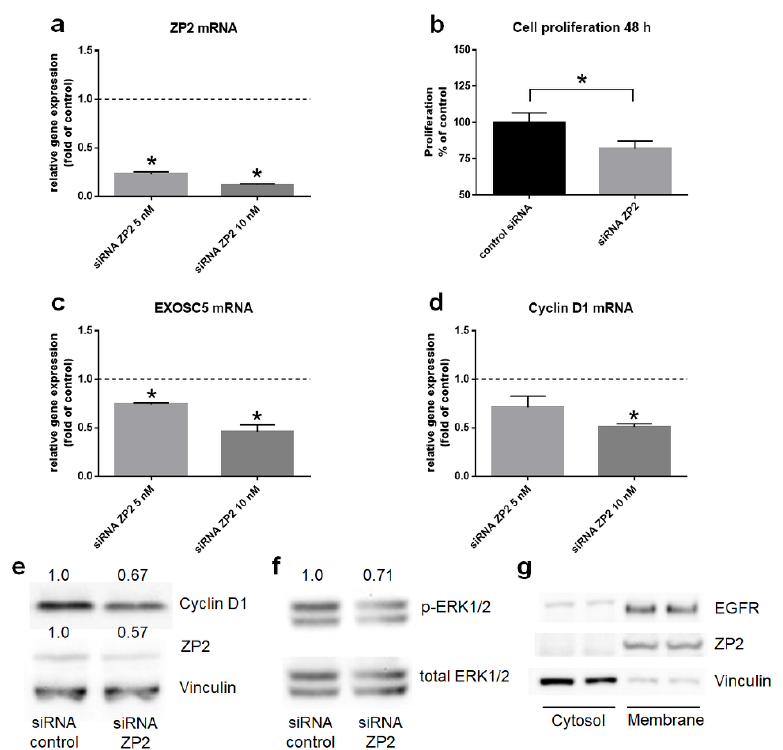
Figure 6. ZP2 silencing effects on colon tumor HT29 cells. ( a ) Decreased expression level of ZP2 after 48 h treatment with its siRNA compared to control siRNA. Untreated control showed no difference compared to control siRNA. Statistically significant differences to control with p < 0.05 are shown with asterisks (*). ( b ) Reduction of cell proliferation rate after treatment with 10 nM siRNA for ZP2 compared to non-stimulated cells as control (= 100% at y-axis). Statistically significant difference with p < 0.05 is shown with an asterisk (*). ( c ) Decreased EXOSC5 mRNA level after incubation with siRNA for ZP2 compared to control siRNA. Statistical significant differences ( p < 0.05) compared to control are designated with asterisks (*). ( d ) Reduced cyclin D1 transcript level after incubation with siRNA for ZP2 compared to control siRNA. Asterisk (*) shows statistically significant difference ( p < 0.05) to control. ( e ) Western blot analysis for cyclin D1 and ZP2 after treatment of HT29 cells with siRNA for ZP2. Vinculin served as internal standard. Numbers show fold change of signal compared to control siRNA (set as “1.0”). Values are means from two independent experiments with standard deviations for cyclin D1 ( ± 0.15) and for ZP2 ( ± 0.11). ( f ) Western blot analysis for phospho-ERK1/2 (p-ERK1/2) after incubation with siRNA for ZP2 compared to total ERK1/2. Numbers show fold change compared to control siRNA (set as “1.0”). Value is mean from two independent experiments with standard deviation ( ± 0.13). ( g ) Western blot analysis for cellular distribution of ZP2, which is highly enriched in the membrane fraction, while the cytosolic marker protein vinculin is mainly detected in the cytosol fraction. EGFR served as the marker for membrane fractions. The fractions were from the same lysate with the same amount of protein (30 µ g) loaded on the